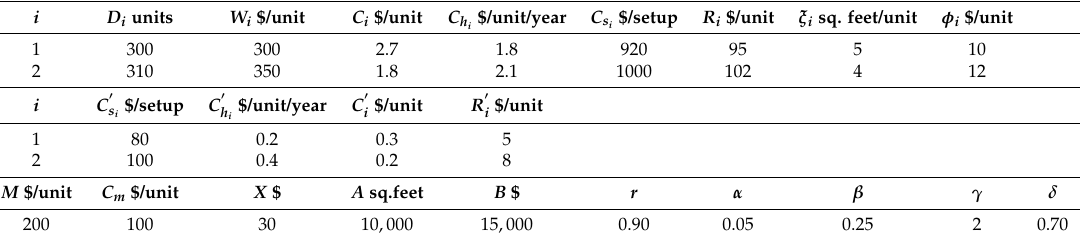
Figure 8. Expected total profit (ETP) versus production rate P 1 of 1st product and failure rate η . Table 2. The optimal values of Example 1.